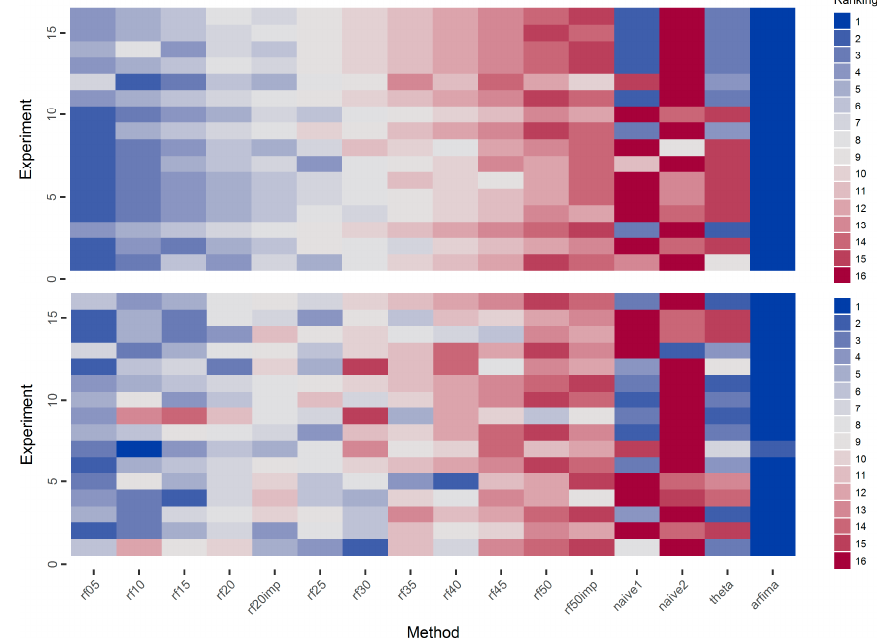
Figure 11. Ranking of methods in each simulation experiment based on the mean ( top ) and median ( bottom ) of the squared errors. Better methods are presented with lower ranking value and blue colours.